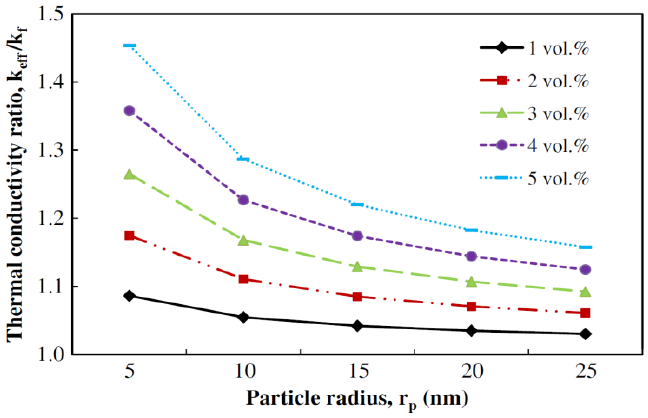
Figure 2. Thermal conductivity ratio as a function of particle size [23].